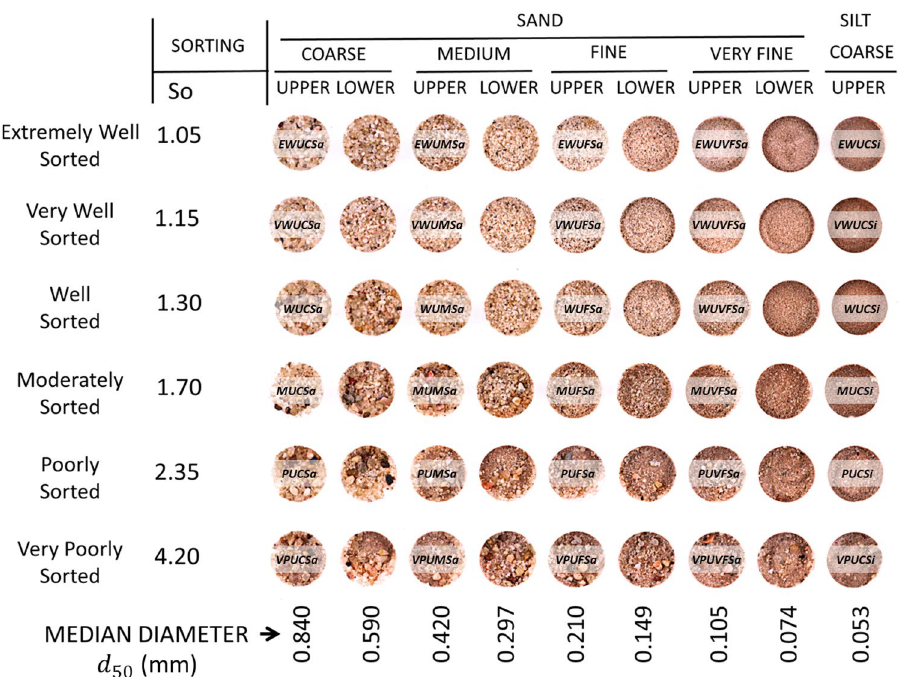
Figure 3. Grain size and grain sorting for unconsolidated sand mixtures 18,41,44 . d 50 : The median grain size. S 0 : Trask sorting coefficient. Full description is also labelled on some sand mixture pictures. Taking the top leftmost sand mixture as an example, EW-U-C-Sa means “Extremely Well Sorted Upper Coarse Sand”. Figure is adapted from Meckel et al. 39